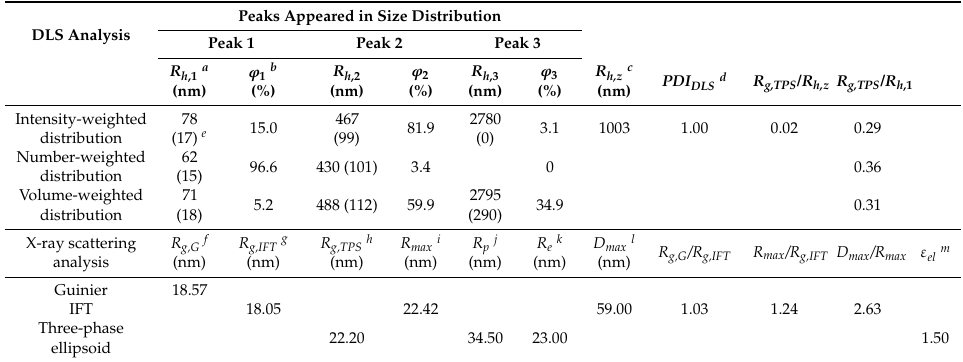
Figure 4. DLS data analysis of the l -PDGE- b -PTEGGE micelle formed in an ethanol/water (75/25 in wt/wt ) mixture: ( a ) autocorrelation function profile measured at 25 ◦ C; ( b ) data analysis result, where the symbols are the measured data and the red solid line was obtained by fitting the data using the Zetasizer program; ( c ) intensity-weighted radius distribution obtained by the data analysis; ( d ) number-weighted radius distribution; ( e ) volume-weighted radius distribution. Table 3. Structural parameters of the normal l -PDGE- b -PTEGGE micelle formed in a mixture of 75 wt % ethanol and 25 wt % water, which were analyzed by DLS and X-ray scattering